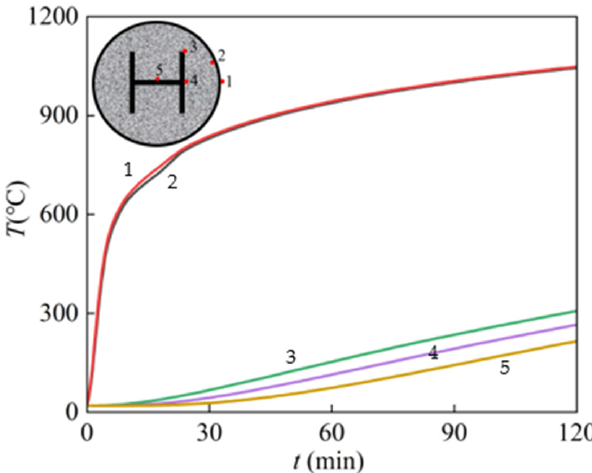
Figure 7. Temperature–time curves.